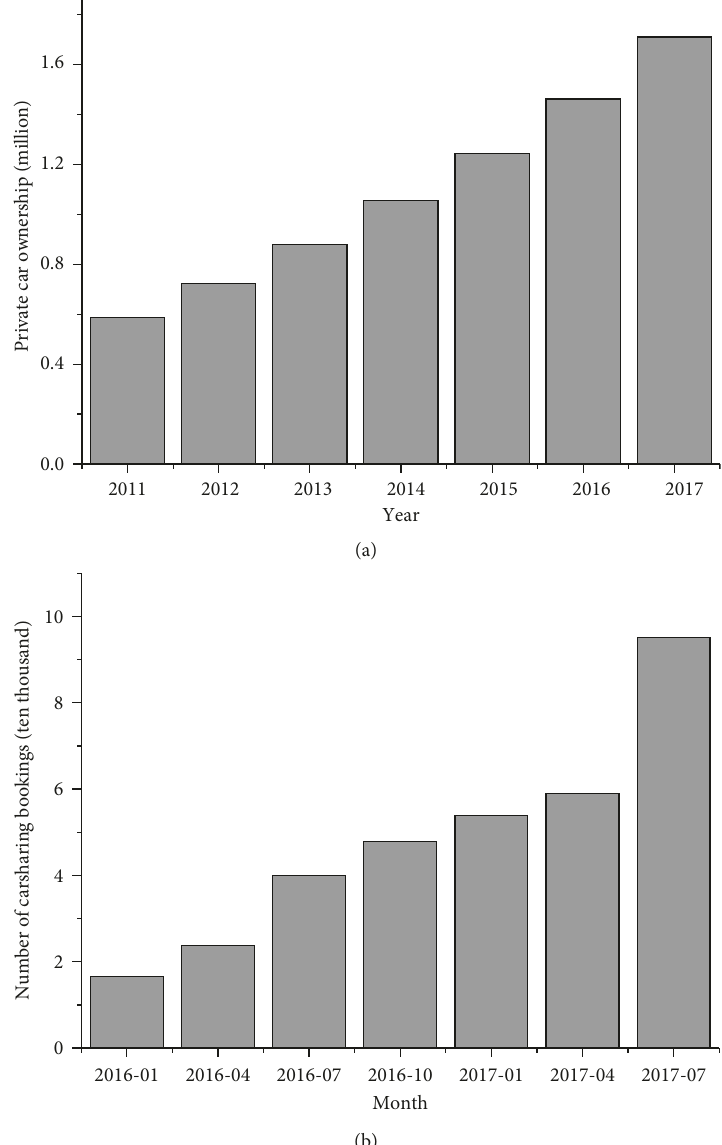
Figure 1: Development of private car ownership and carsharing order: (a) private car ownership in China and (b) carsharing order quantity in